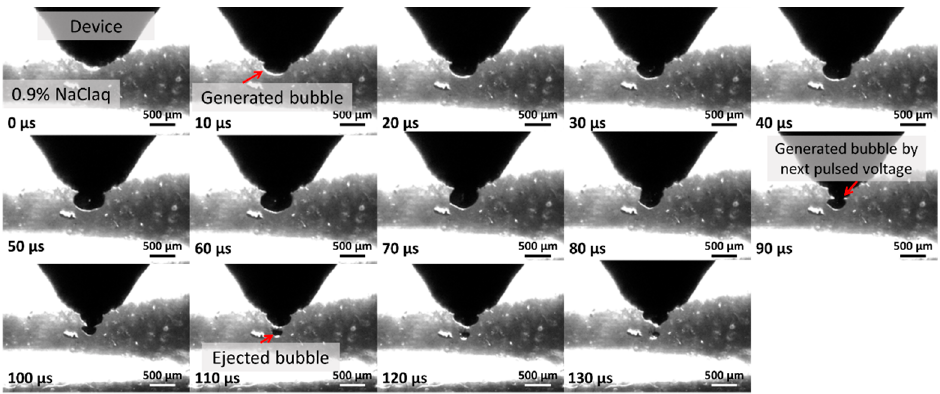
Figure 3. Sequence photographs of the bubble generation and ejection taken at 500,000 fps by an ultra-high-speed camera (HPV-X2, SHIMADZU, Kyoto, Japan).